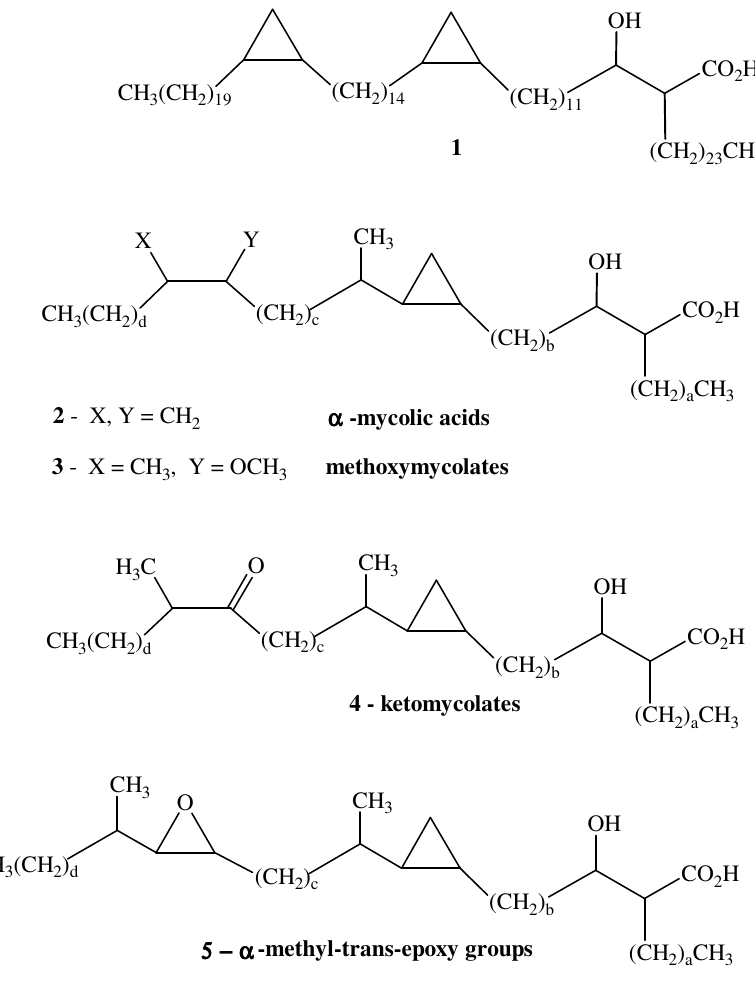
FIGURE 1. Some compounds of the mycolic acid